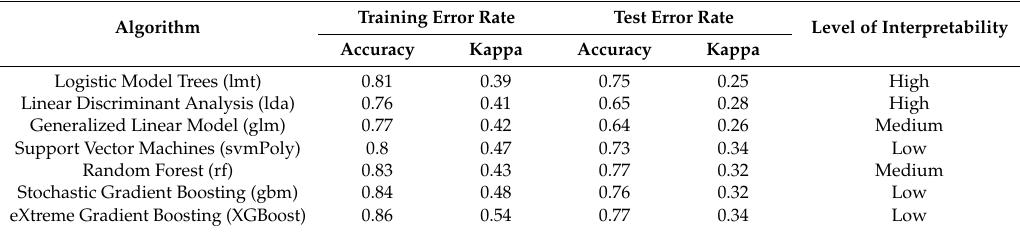
Table 3. Algorithms applied, training, testing metrics, and level of interpretability.